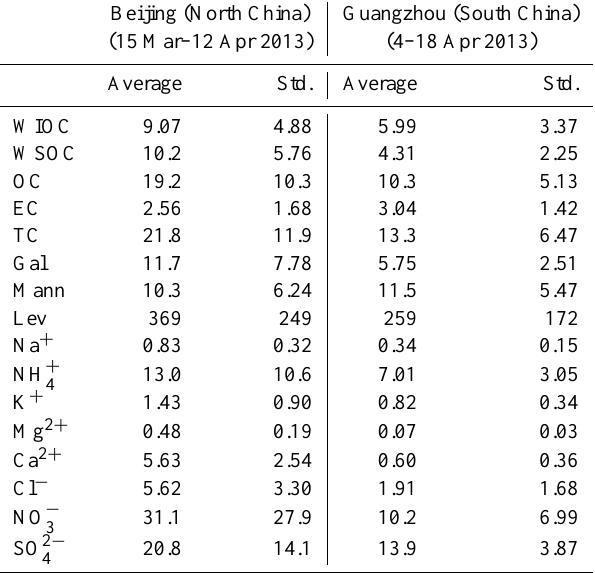
Table 1. Data set (average values with standard deviation) for the measured components in this study. Units for the carbon fractions, anhydrosugars and ions are µg C, ng, and µgm − 3 , respectively. Beijing (North China) Guangzhou (South China) (15 Mar–12 Apr 2013) (4–18 Apr 2013) Average Std. Average Std. WIOC